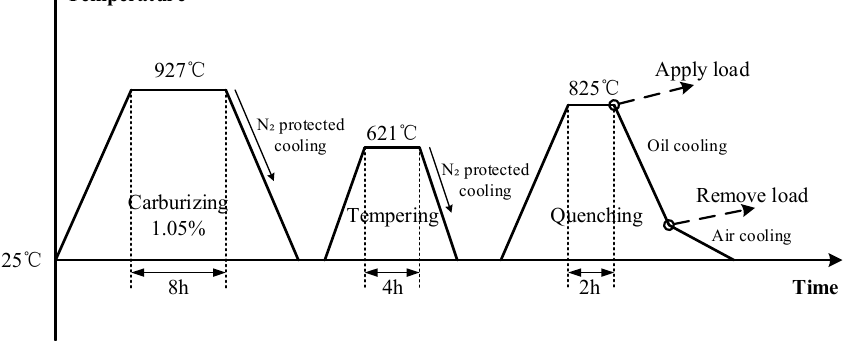
Figure 5. Process curve for the die quenching of the face gear.